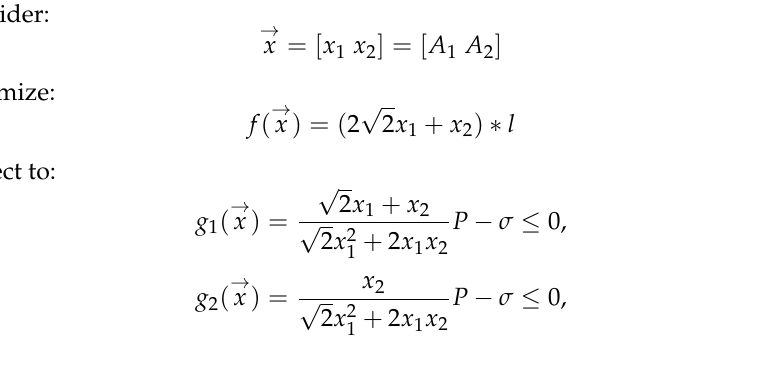
Figure 13. Schematic diagram of three-bar truss design.